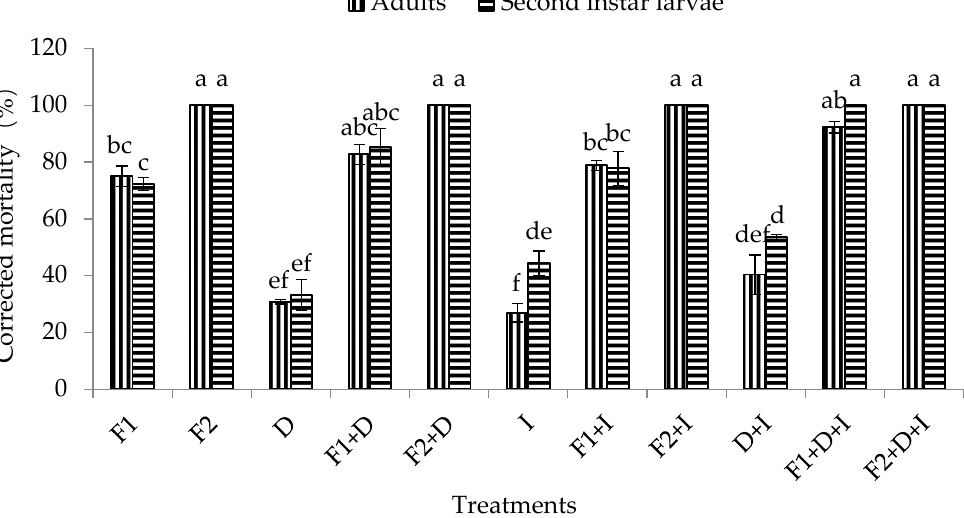
Figure 3. E ff ect of conidia concentrations of M. flavoviride associated with DE and imidacloprid on the mortality of adults and second instar larvae of WFT ( F. occidentalis ). Bars with the same letter above the bar are not significantly di ff erent (Tukey’s HSD at p = 0.05). Error bars denote SE values. D = DE at 200 ppm, F1 = M. flavoviride at 1.2 × 10 6 conidia / mL, F2 = M. flavoviride at 1.2 × 10 8 conidia / mL, I = imidacloprid at 50 ppm, D + I = DE at 200 ppm + imidacloprid at 50 ppm, D + F1 = DE at 200 ppm + M. flavoviride at 1.2 × 10 6 conidia / mL, D + F2 = DE at 200 ppm + M. flavoviride at 1.2 × 10 8 conidia / mL, I + F1 = imidacloprid at 50 ppm + M. flavoviride at 1.2 × 10 6 conidia / mL, I + F2 = imidacloprid at 50 ppm + M. flavoviride at 1.2 × 10 8 conidia / mL, D + I + F1 = DE at 200 ppm + imidacloprid at 50 ppm + M. flavoviride at 1.2 × 10 6 conidia / mL, D + I + F2 = DE at 200 ppm + imidacloprid at 50 ppm + M.